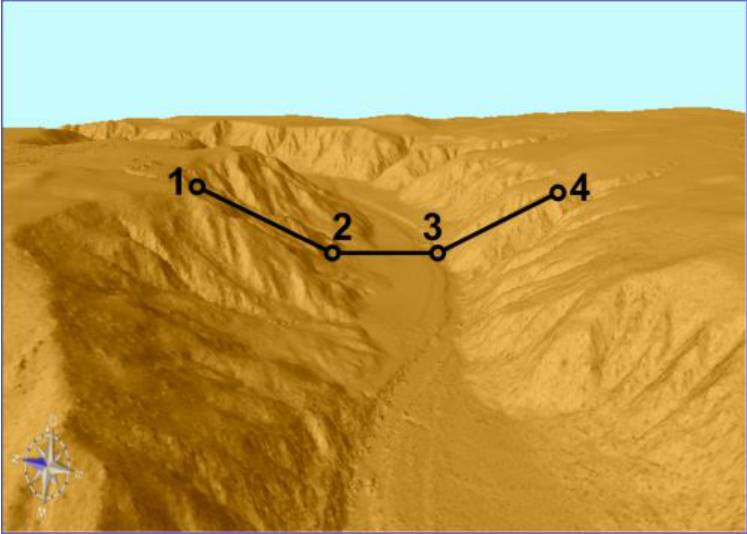
Figure 2. A cross-section of a canyon with its four characteristic